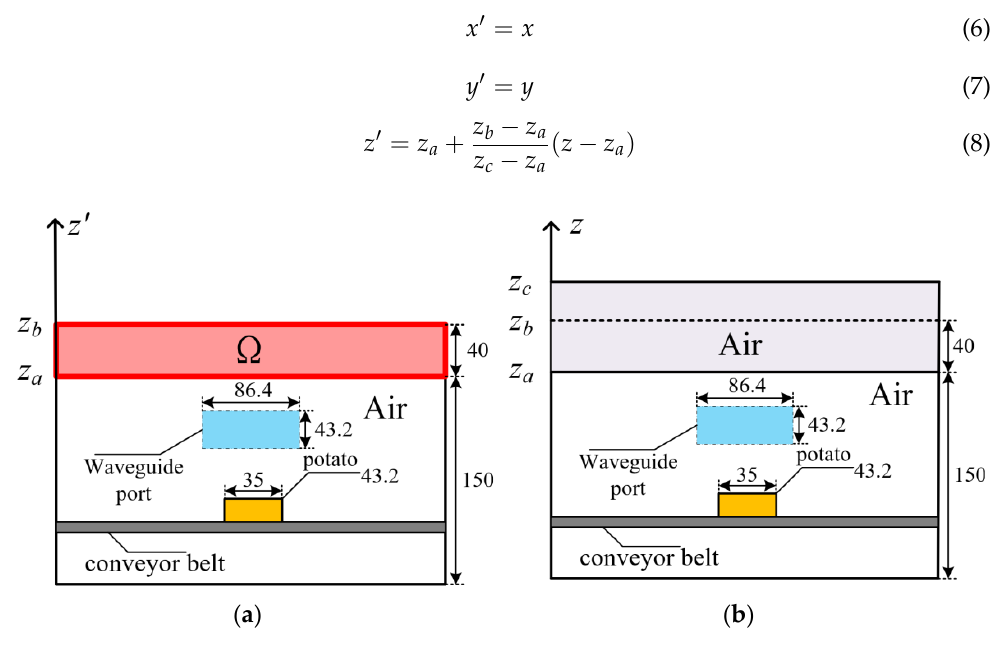
Figure 2. The diagram of coordinate transformation of the 2-D cross section of the proposed cavity model. ( a ) transformation optical model ( b ) actual stretched position with original coordinate sys- tem.